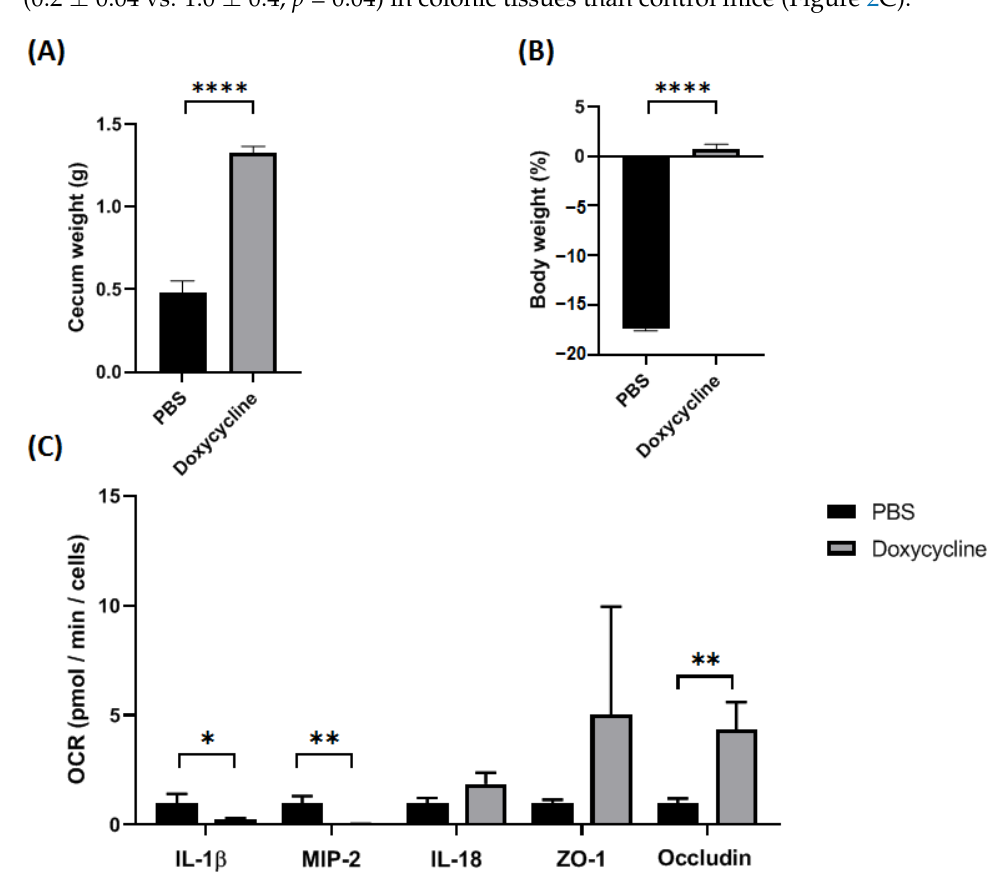
Figure 2. Cecum weight ( A ) and body weight ( B ) reduction and mRNA expression of inflammatory cytokine and tight junction protein genes ( C ) in colonic tissue from mice receiving doxycycline followed by oral challenge of vegetative cells of a toxigenic Clostridioides difficile strain. The values are expressed as means ± standard errors. (A: ****, p < 0.001; B: ****, p < 0.001; C: *, p = 0.04; **, p < 0.01). Characters of epithelial inflammation, including neutrophil infiltration, epithelial dam- age, and irregular shape of colon mucosa, were noted in the pathology control (PBS) (red arrow in Figure 3). In contrast, in doxycycline-exposure mice, these epithelial inflamma- tion characters were not obvious. After calculating the pathologic score, fewer neutrophil infiltrations (1.8 ± 0.8 vs. 4.4 ± 0.9/HPF, p = 0.001) and lower pathologic scores (2.4 ±